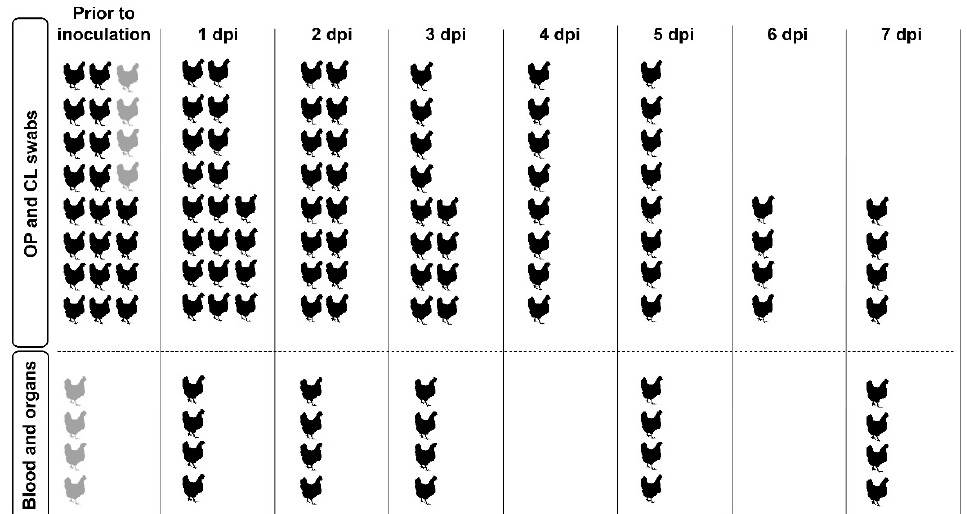
Figure 1. Sample collection per experimental group. A total of 184 six-week-old specific pathogen free (SPF) White Leghorn chickens were divided into eight experimental groups of 20 chickens (virus-inoculated groups) and one experimental group of 24 chickens (control group). Prior to inoculation, oropharyngeal (OP) and cloacal (CL) swabs were collected from all chickens of each experimental group to confirm the absence of current AI virus infection. In addition, blood and organs were collected from four chickens in the control group (shown in grey). After inoculation, OP and CL swabs were taken from live birds daily to seven days post inoculation (dpi) to determine viral shedding. Four chickens from each experimental group were euthanized at 1, 2, 3, 5, and 7 dpi to collect blood and organs. The experiment was terminated at 7 dpi.